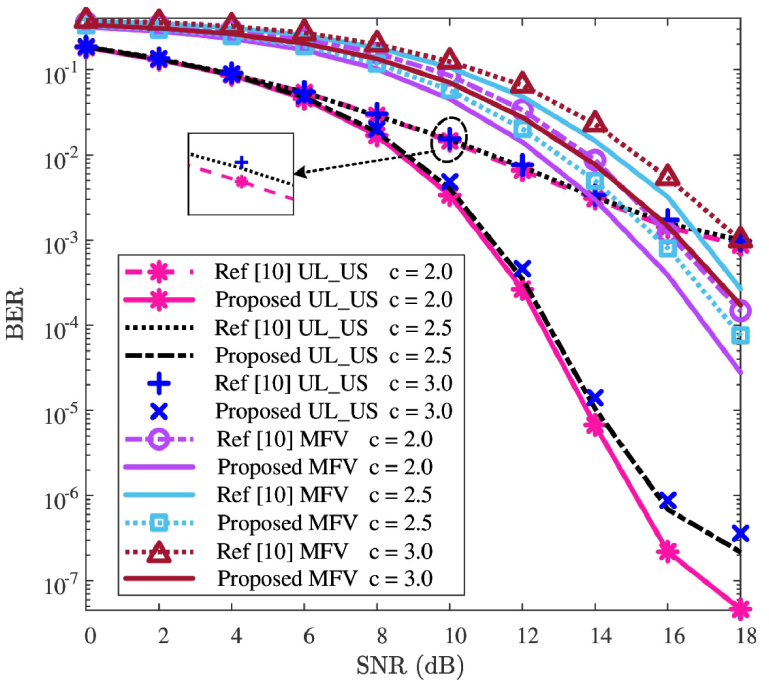
Fig 7. BER versus SNR, where P = 512 and ρ = 0.10 are